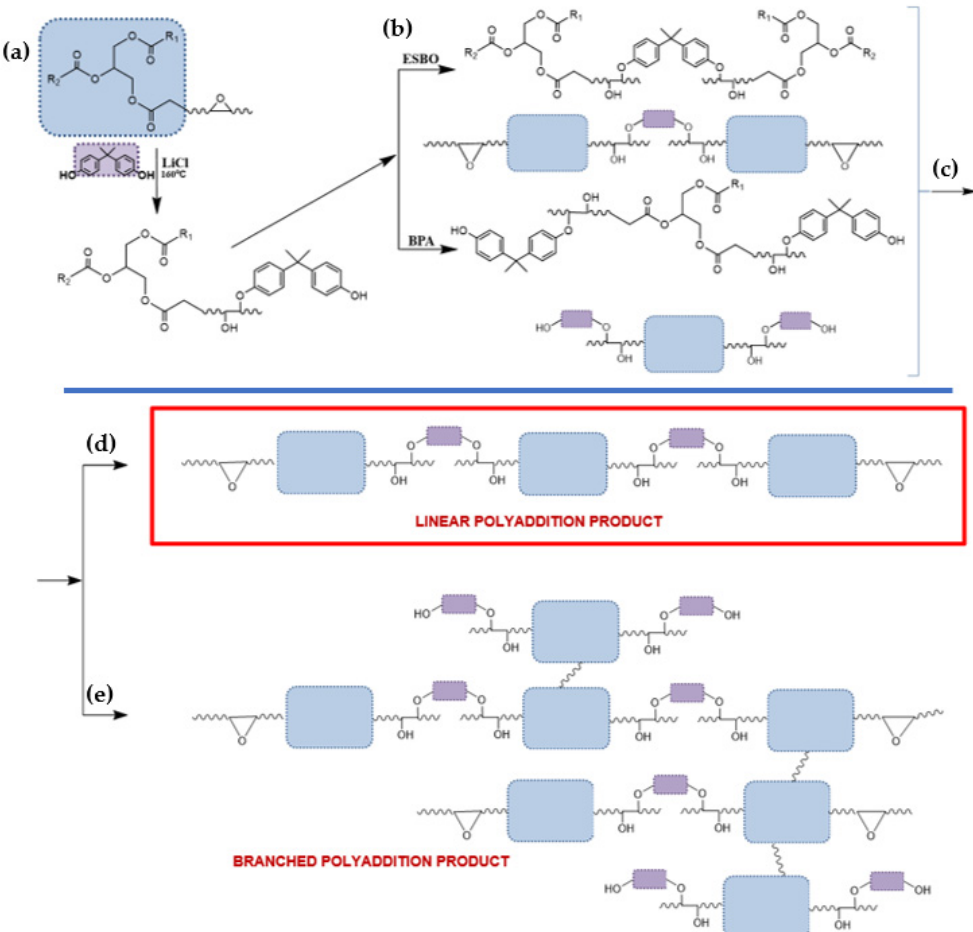
Figure 4. The ESBO_BPA epoxy fusion process: ( a , b ) 1st step—polyaddition reaction of epoxidized vegetable oil and BPA, ( c ) reaction of the dimer formed in the first stage of the polyaddition process, ( d ) formation of a linear fusion product, and ( e ) formation of a branched ESBO_BPA product.